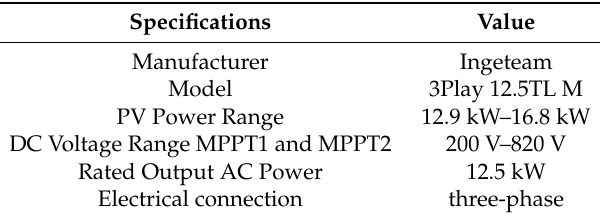
Table 3. PV inverter technical